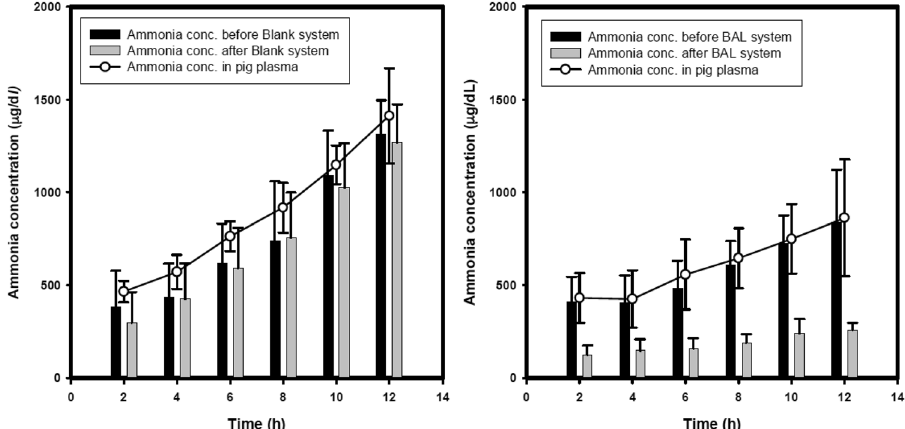
Figure 4. Ammonia levels recorded in the extracorporeal circulation in the ( A ) blank group and ( B ) BAL group during 12-hour treatment. Significant decrease in ammonia in the plasma exiting the extracorporeal circulation system (grey bars) compared to the plasma entering the extracorporeal circulation system (black bars) is observed in the BAL group ( B